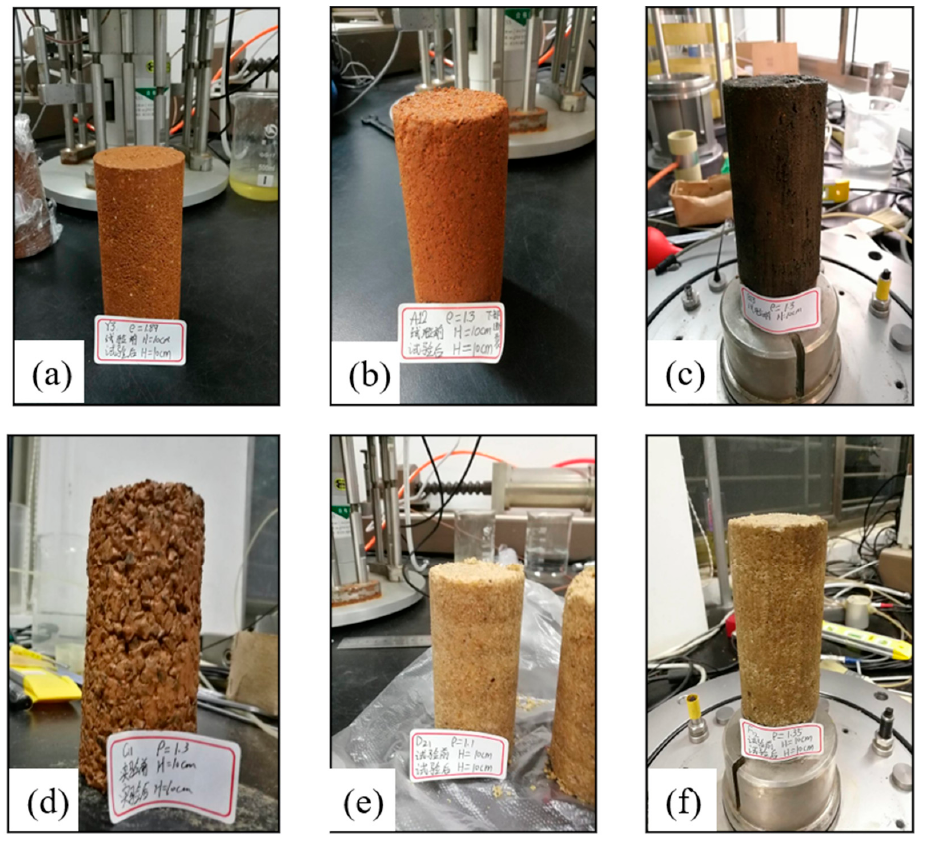
Figure 2. Original soil and model soil samples prepared: ( a ) Undisturbed soil, ( b ) Sawn soil sample,